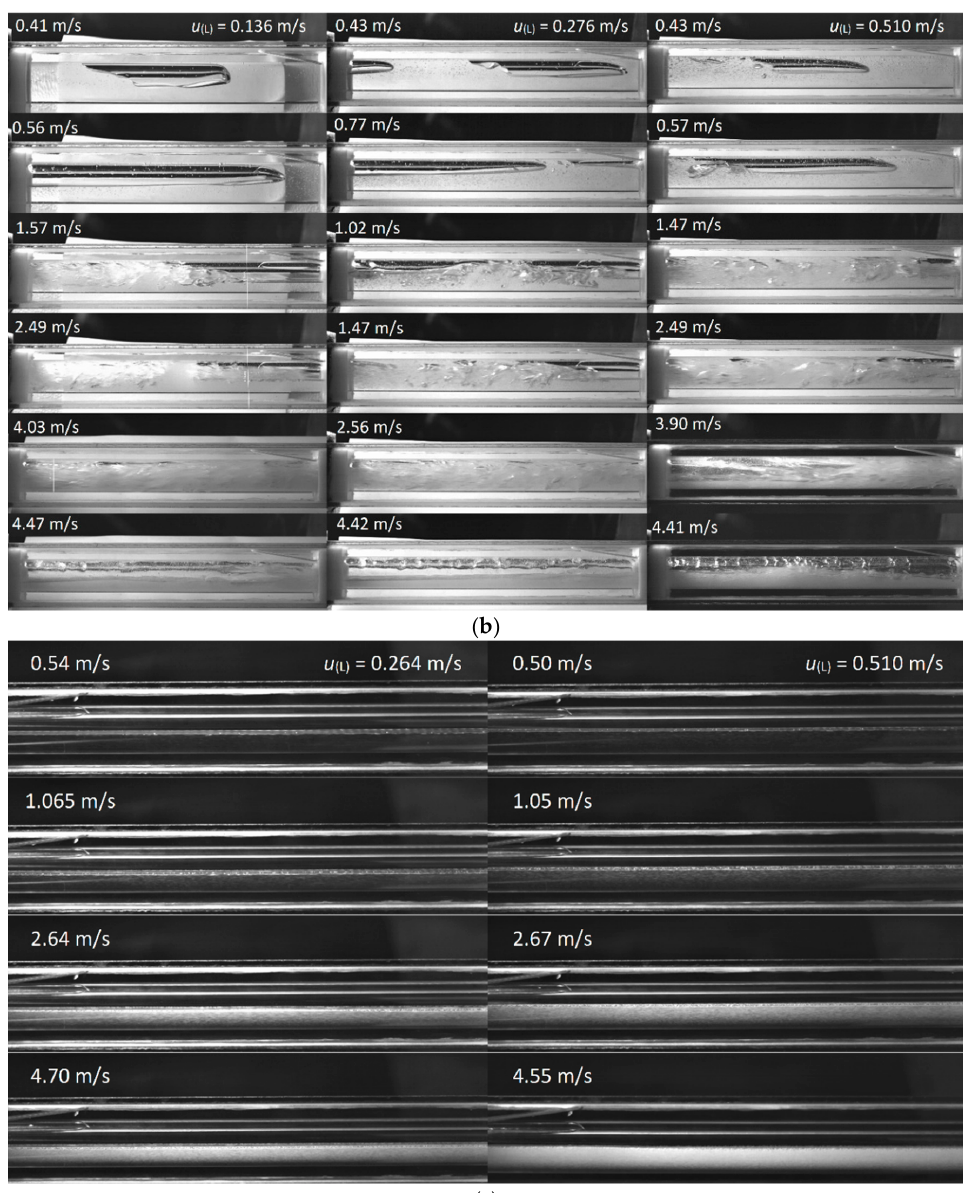
Figure 8. Snapshots from the HSCI ( a ) for horizontal inclination (0°), ( b ) for upward inclinations (9°), and ( c ) for a downward inclination (9°): at u ( L ) = 0.136, 0.264, and 0.510 m / s and varying u ( G